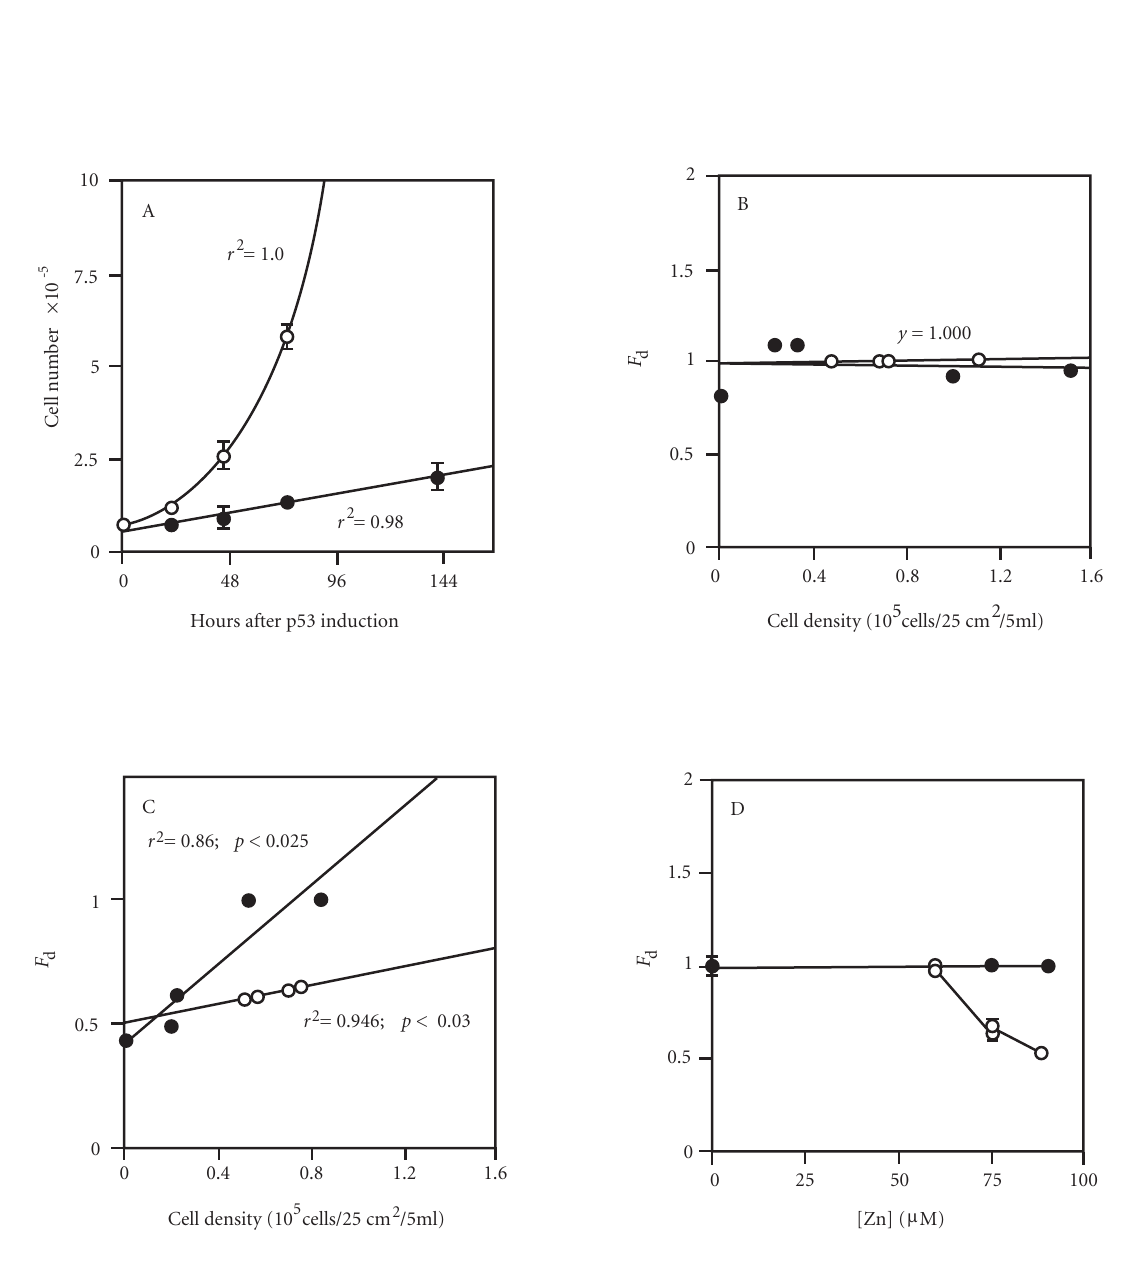
Figure 2: Density-dependent p53 growth regulation reflects induction of linear population growth kinetics. (A), Linear growth by p53- expressing fibroblasts. Growth data for [19] as a function of the initial cell density of temperature-dependent (closed circles) and Zn - dependent times in Figure 1. (B), Control cells. (C), p53-inducible cells. (D), Response of linear kinetics to p53 level induced by increasing Zn concentration [26]. The initial cell density ranged from 0.44 to 1 . 1 × 10 5 cells/25cm 2 /5ml. Two to six independent bars indicate the standard